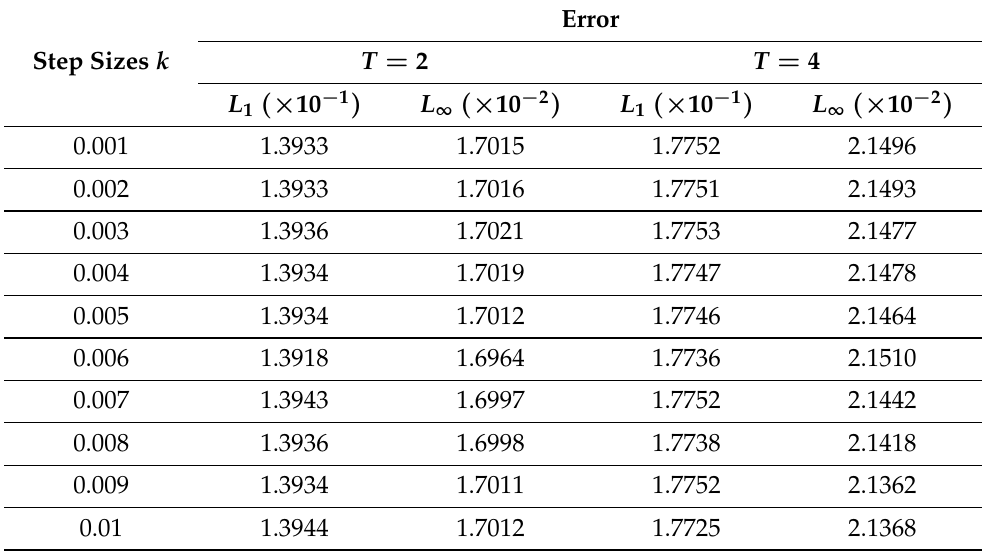
Table 1. L 1 and L ∞ errors for various k when h = π /10 when Scheme 1 is employed to approximate Numerical Experiment 1 at T = 2 and T =